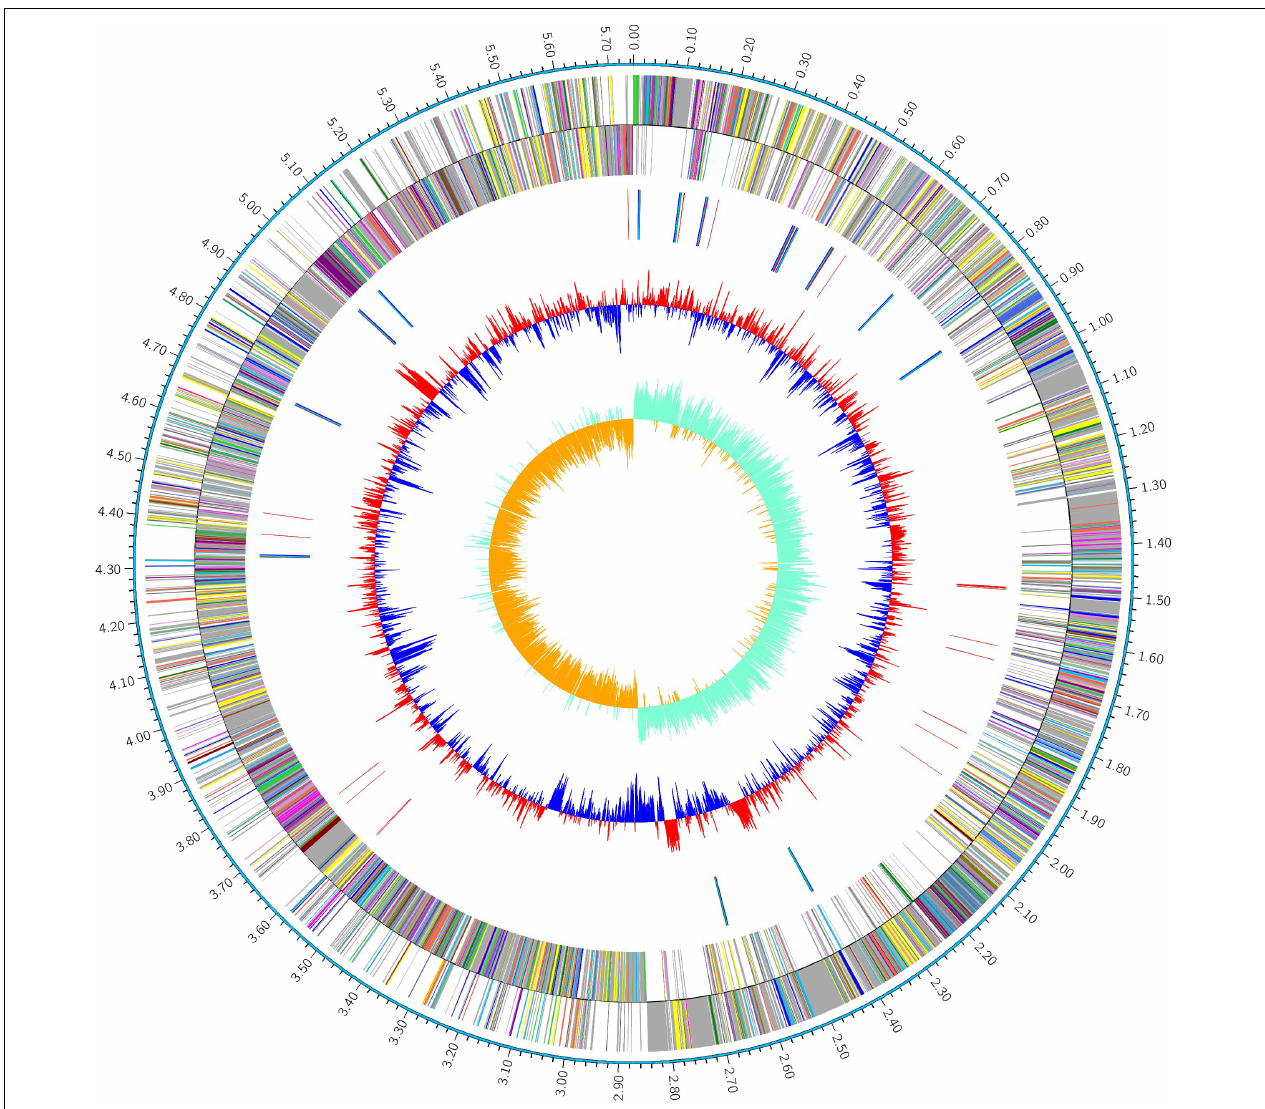
FIGURE 1 | Circular map of the genome of the P. polymyxa strain HY96-2. The distribution of the circle from the outside to the inside indicates the genome size, forward CDS, reverse CDS, repeat sequences, tRNA (blue), rRNA (purple), GC ratio (red and blue indicate regions where the GC ratio is higher than average and lower than average, respectively), and GC skew (cyan and orange indicate regions where the G content is greater than and less than the C content,